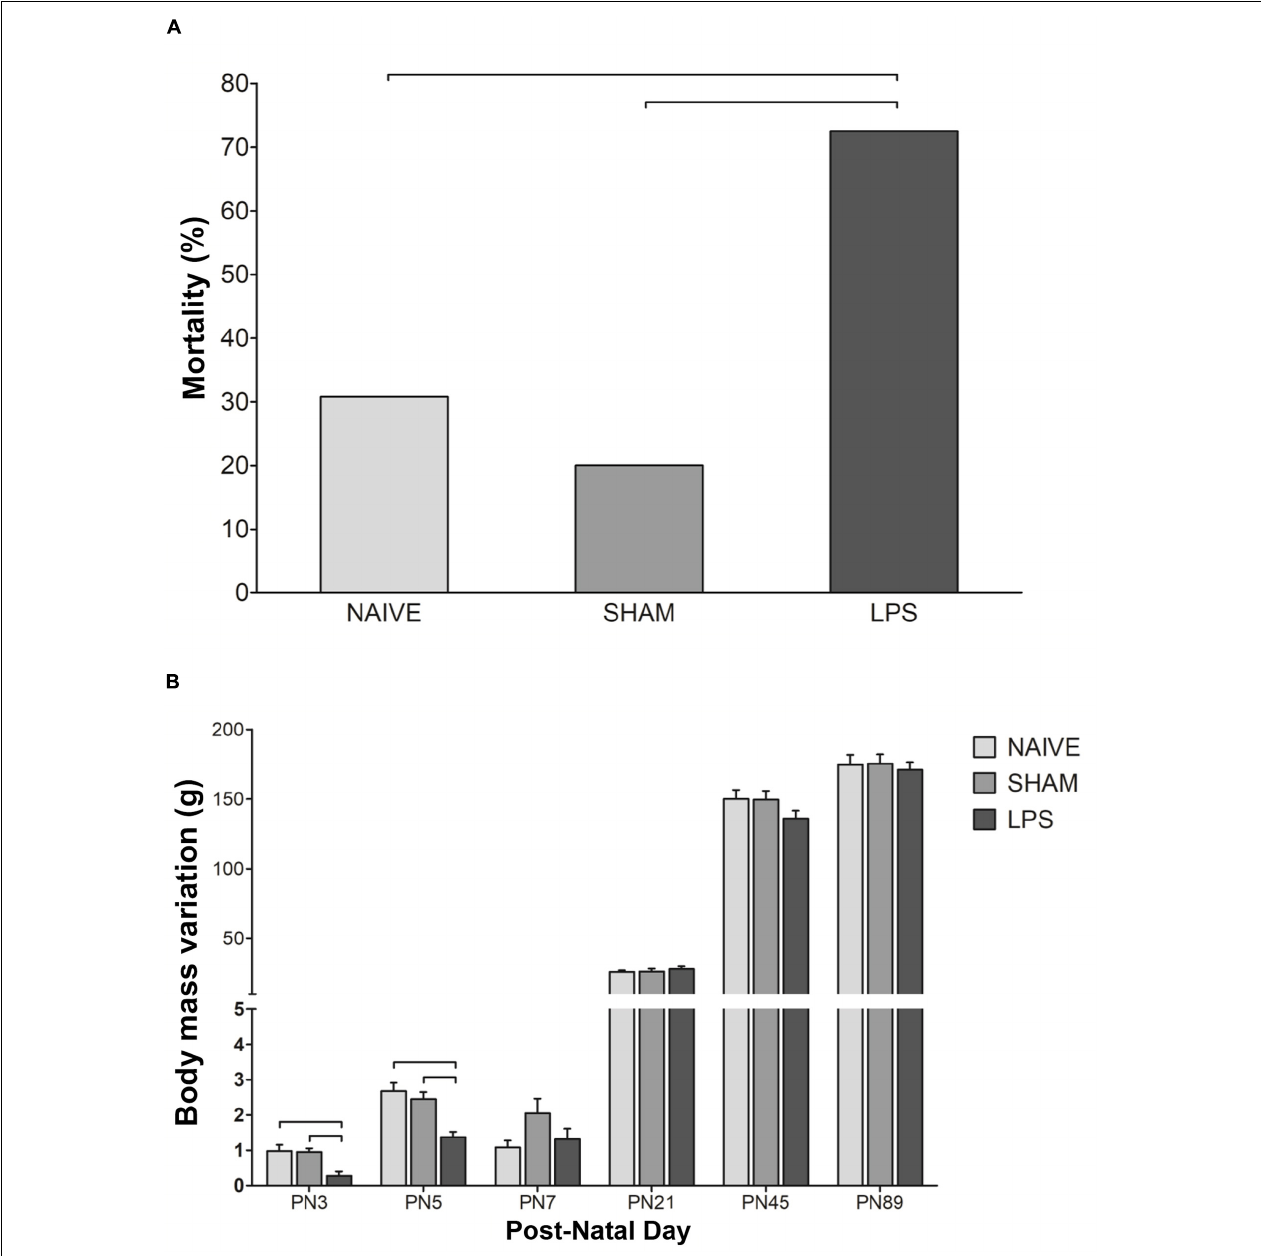
FIGURE 1 | Mortality rate and weight change after neonatal LPS-induced inflammation. (A) Mortality rate in the LPS group was higher than in control groups. Values: percentage, χ 2 (2) = 13.006; bars: p < 0.01. (B) Neonatal LPS administration caused transient body weight change. Values: mean ± SEM, ANOVA, Tukey post hoc test, bars: p < 0.01 vs control groups on PN3 and